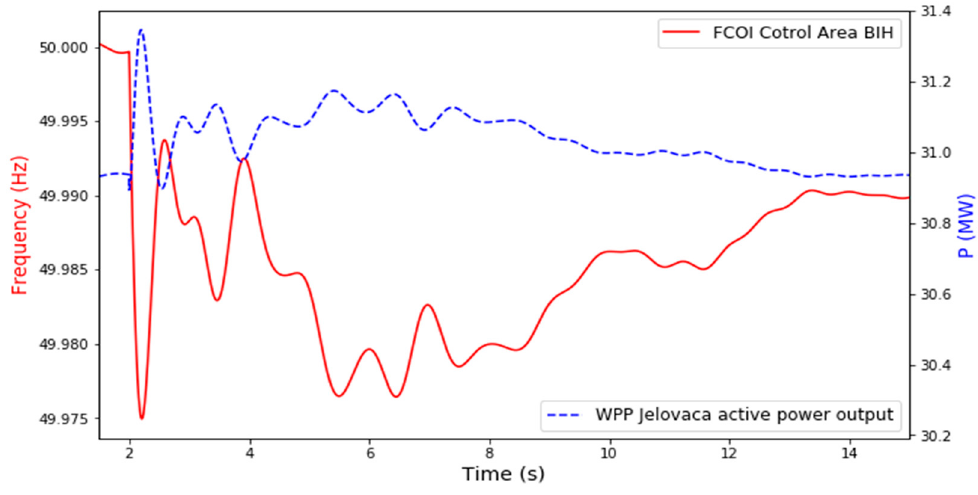
Figure 10. WPP Jelovaca (BIH) active power response.